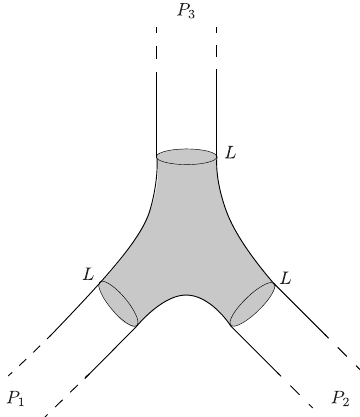
Figure 4 . The surface V 0 , 3 ( L ) is the three-punctured sphere obtained by attaching three semi- infinite cylinders of circumference L to the geodesic boundaries of the symmetric hyperbolic pants with boundary lengths all set equal to L